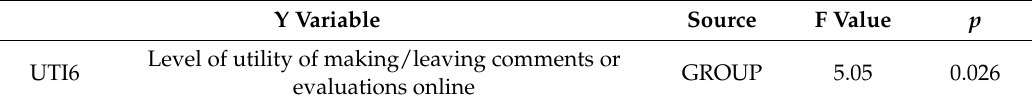
Table 5. Model with UTI6 “Level of utility of making/leaving comments or evaluations online”.